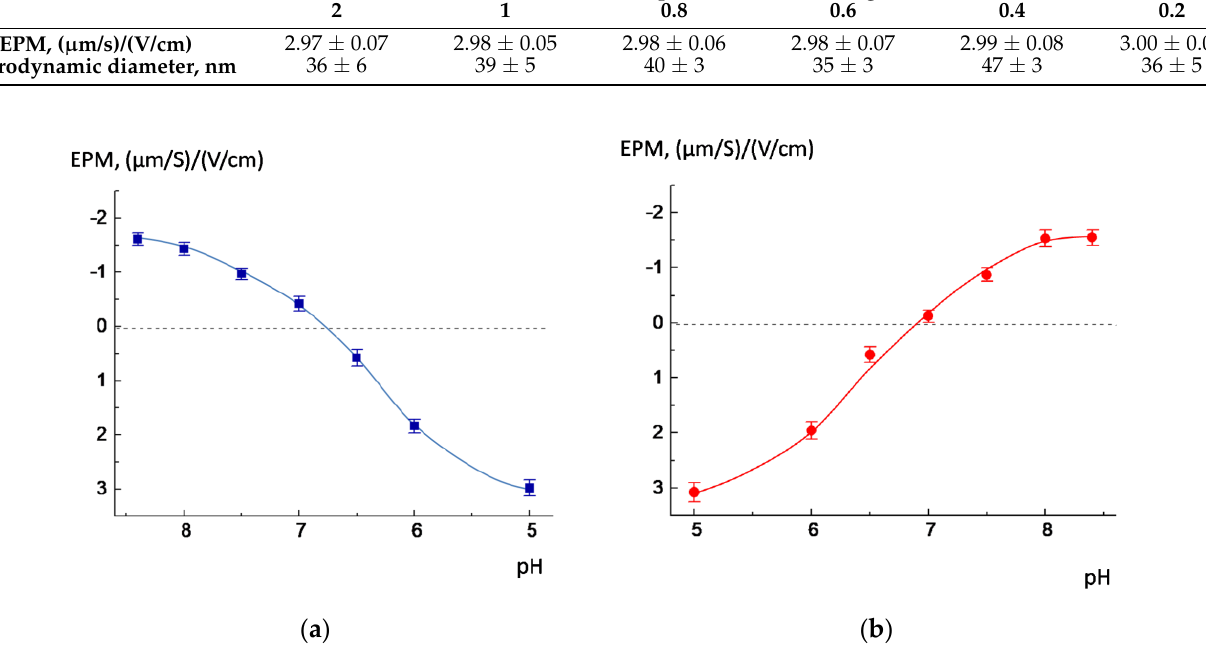
Figure 2. The EPM of POPC/AMS liposomes ( α AMS = 0.1) prepared in a pH 8.4 buffer ( a ) and in a pH 5.0 buffer ( b ) and then transferred to buffers with different pH values. Lipid concentration 1 mg/mL. α AMS = 0.1. The dashed line indicates the value of the EPM that is equal to